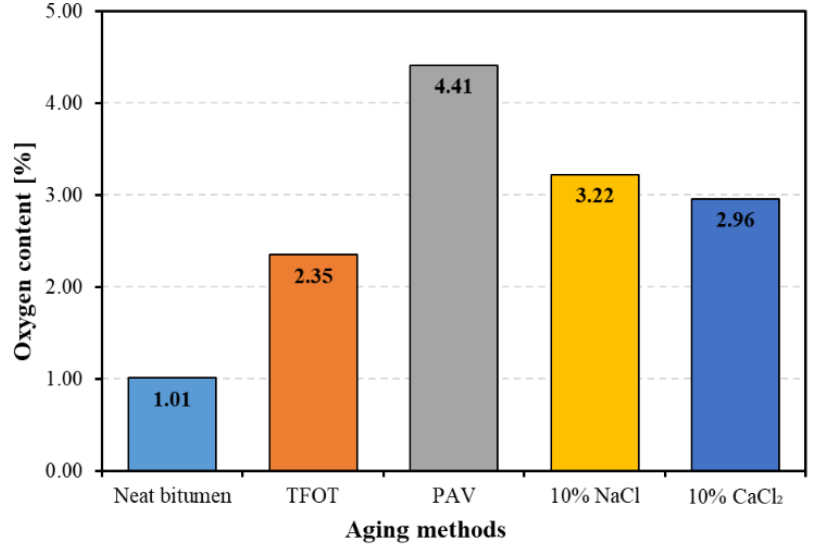
Figure 2. The oxygen content of bitumen before and after aging.